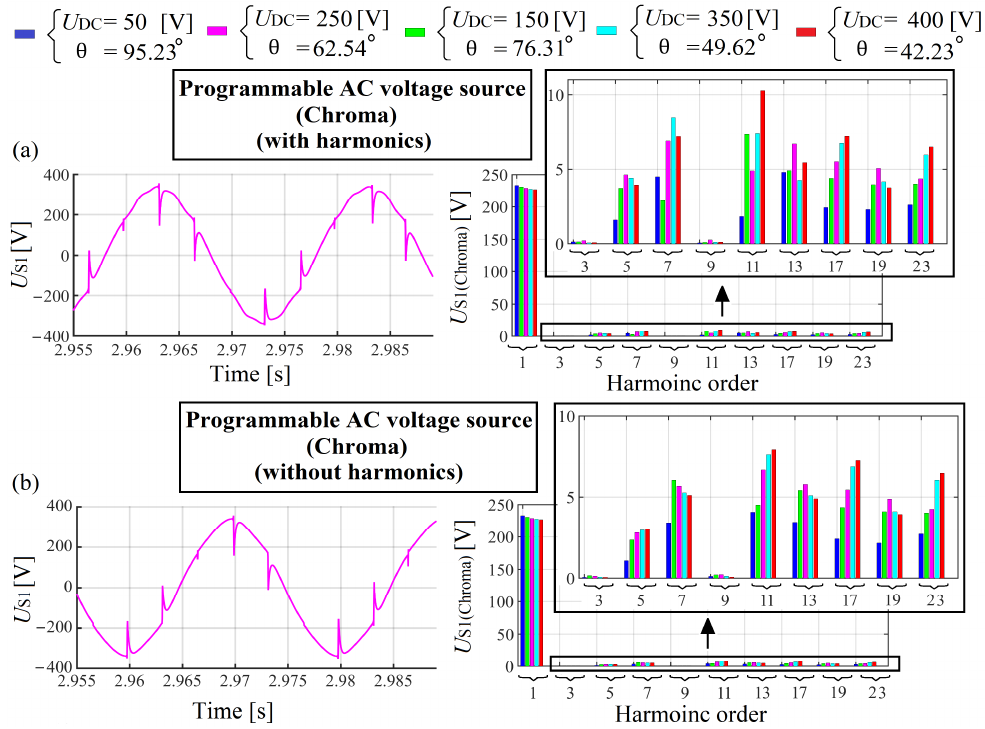
Figure 32. PCC voltage waveforms and spectrums measured at the PCC when the programmable voltage source was: ( a ) with harmonics and ( b ) without harmonics. The line reactor L SS is considered.